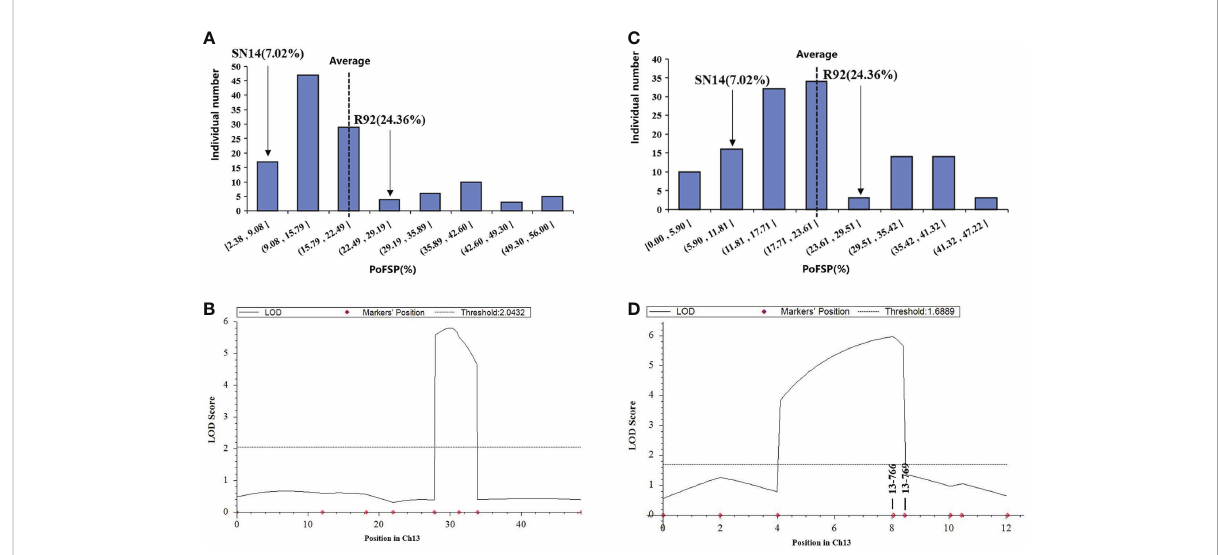
FIGURE 5 Phenotypic identi fi cation and QTL results of fi ne-mapping populations. (A) : Frequency histogram of the phenotypic distribution of PoFSP in the R92-F 2 . (B) : QTL mapping results of ICIM method in R92-F 2 . (C) : Frequency histogram of the phenotypic distribution of PoFSP in the H1. (D) : QTL mapping results of ICIM method in